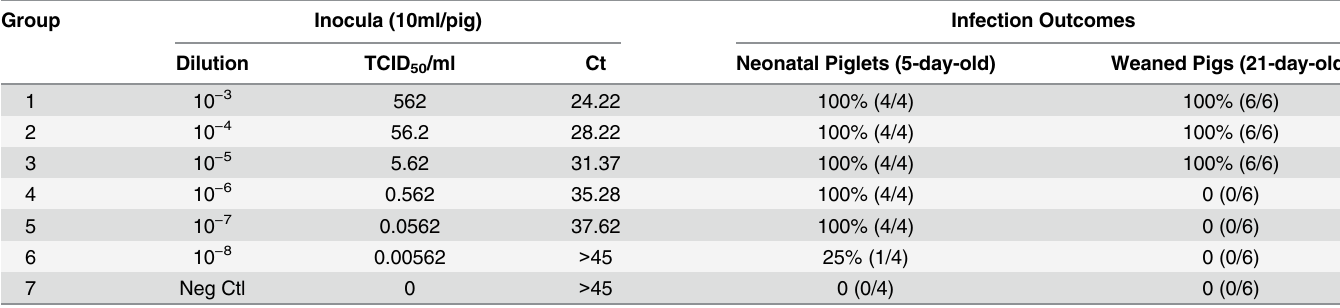
Table 6. Summary of PEDV infection outcomes in neonatal and weaned pigs.